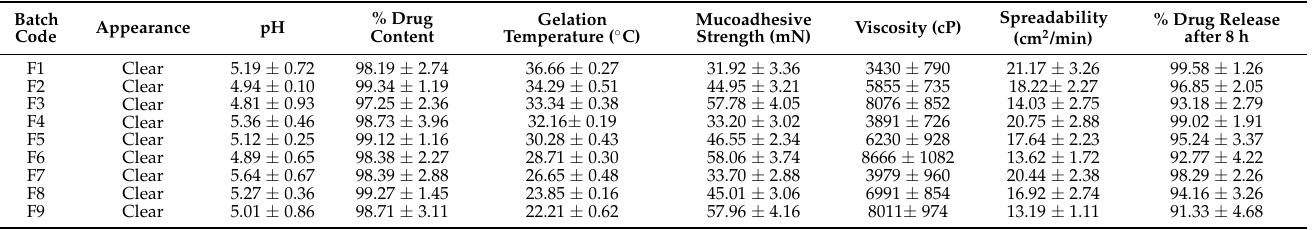
Table 2. Physicochemical characteristics of preliminary batches (F1–F9) of nasal in situ gel contain- ing